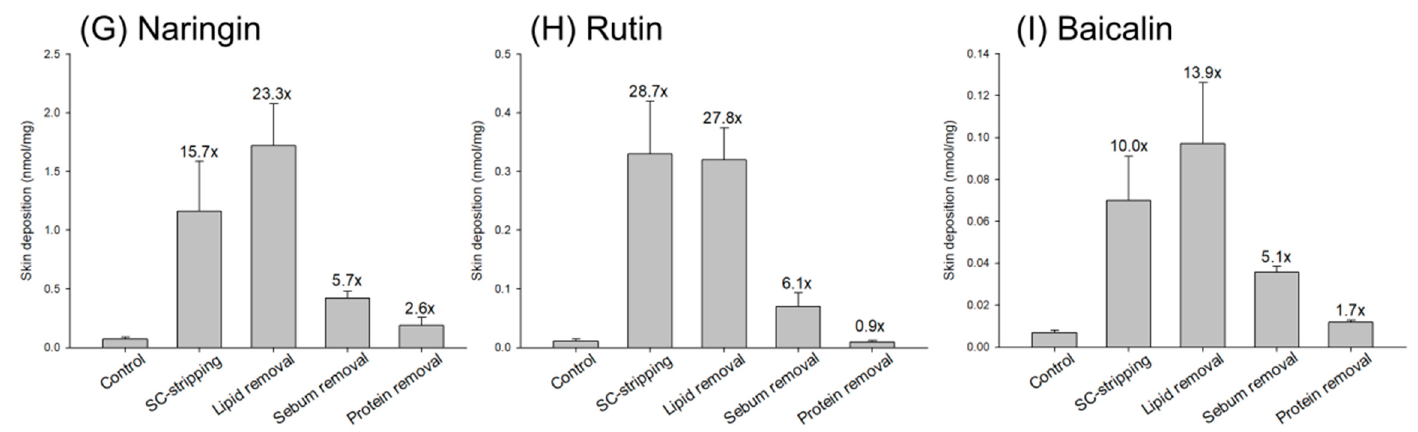
Figure 4. The released percentage and skin deposition of flavonoids (6 mM) via cellulose membrane, stratum corneum (SC)-stripped skin, delipid skin, desebum skin, and deprotein skin: ( A ) released percentage of flavonoids across cellulose membrane; ( B ) skin deposition of myricetin in SC-disrupted skins; ( C ) skin deposition of naringenin in SC-disrupted skins; ( D ) skin deposition of quercetin in SC-disrupted skins; ( E ) skin deposition of kaempferol in SC-disrupted skins; ( F ) skin deposition of baicalein in SC-disrupted skins; ( G ) skin deposition of naringin in SC-disrupted skins; ( H ) skin deposition of rutin in SC-disrupted skins; and ( I ) skin deposition of baicalin in SC-disrupted skins. All data are presented as the mean of four experiments ± S.D.